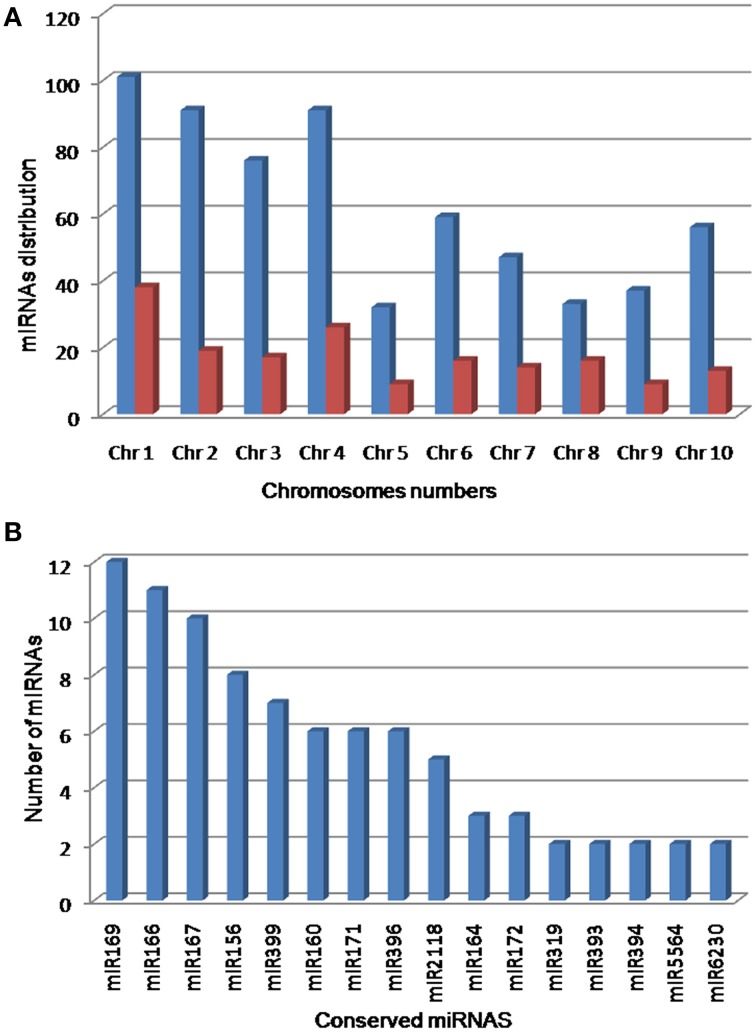
Distribution of predicted miRNAs. Chromosomal distribution (A) showed that the maximum numbers of miRNAs were predicted from chromosome 1 and 4. Distribution of conserved miRNAs (B) showed that miR169, miR166, and miR167 were the most abundant miRNAs in sorghum genome.